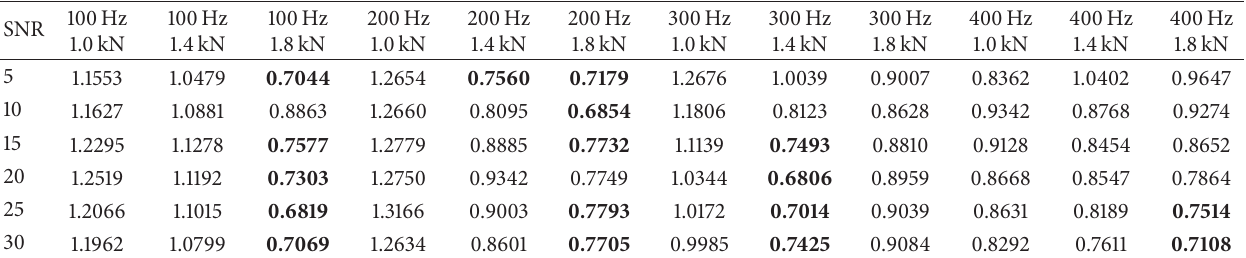
Table 3: The Margin calculated using the proposed algorithm (PIEEMD) in 𝑌 direction.